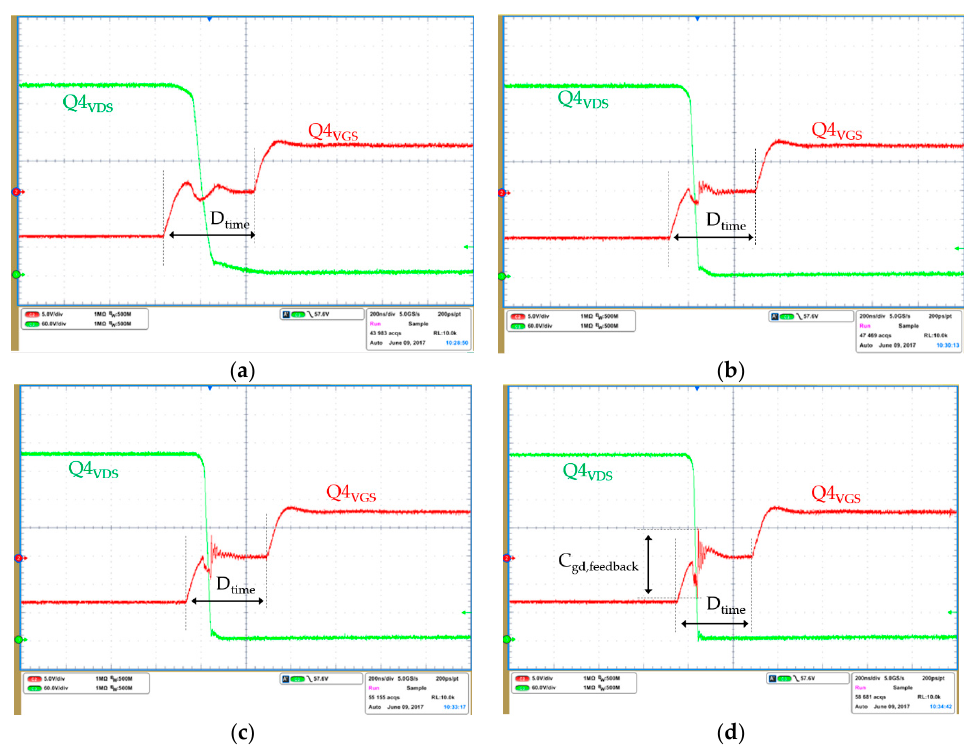
Figure 23. Turn on switching waveforms of the low side switch of the leading leg at different loads (I o,avg ). ( a ) 25 A; ( b ) 60 A; ( c ) 75 A; ( d ) 117 A.